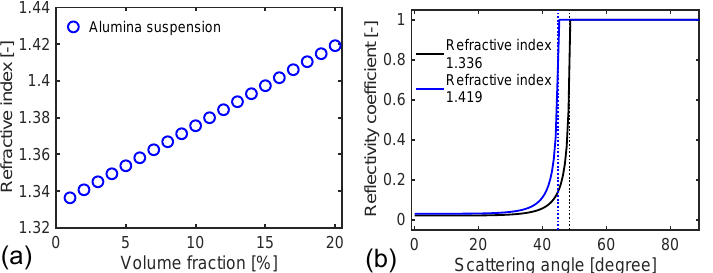
Figure 2. ( a ) Refractive indices of the alumina suspension at different volume fractions from 1% to 20%. ( b ) Reflectance as a function of the scattering angle at different refractive indices of 1.336 ( η = 0.01) and 1.419 ( η = 0.20) with the critical angles of 48.4 ◦ and 44.8 ◦